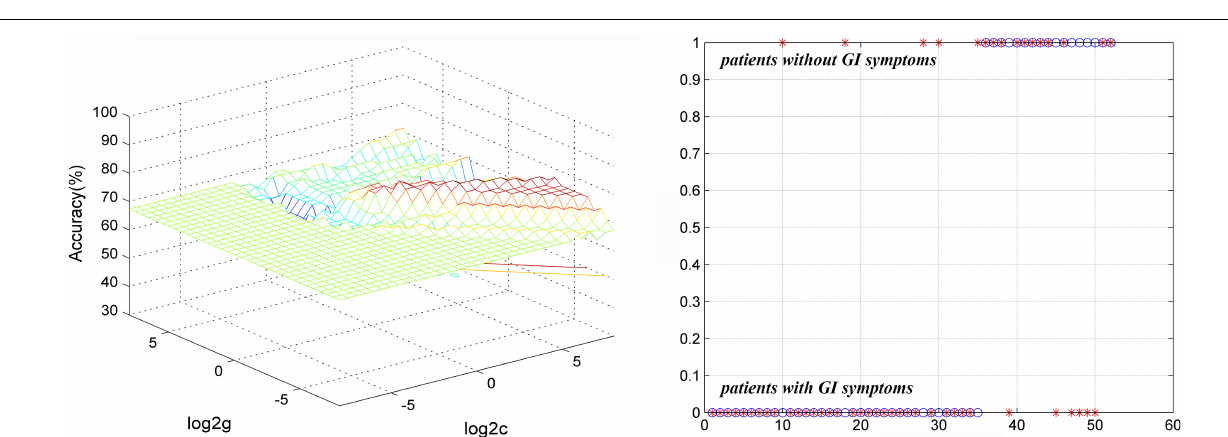
FIGURE 5 | Visualization of classifications through SVM using abnormal GFC values of the left superior MPFC to discriminate MDD with and without GI symptoms. (Left) SVM parameters result of 3D view. (Right) Classified map of GFC of the left superior MPFC. SVM, support vector machine; GFC, global functional connectivity; MPFC, medial prefrontal gyrus; MDD, major depressive disorder; GI, gastrointestinal